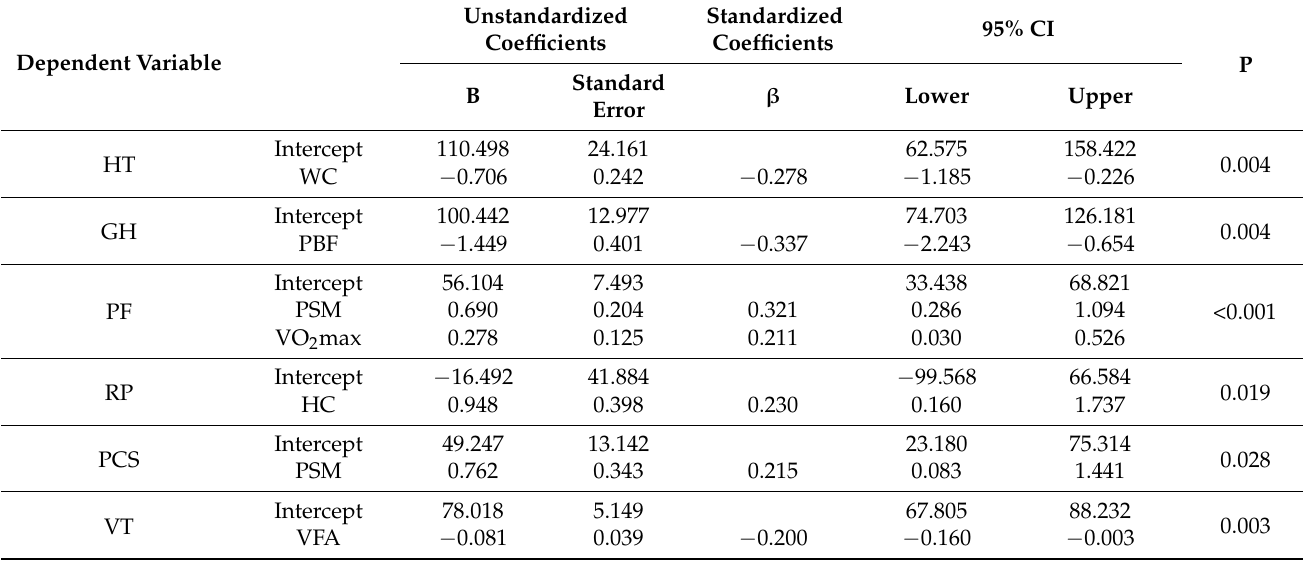
Table 4. Multiple regression analysis of quality of